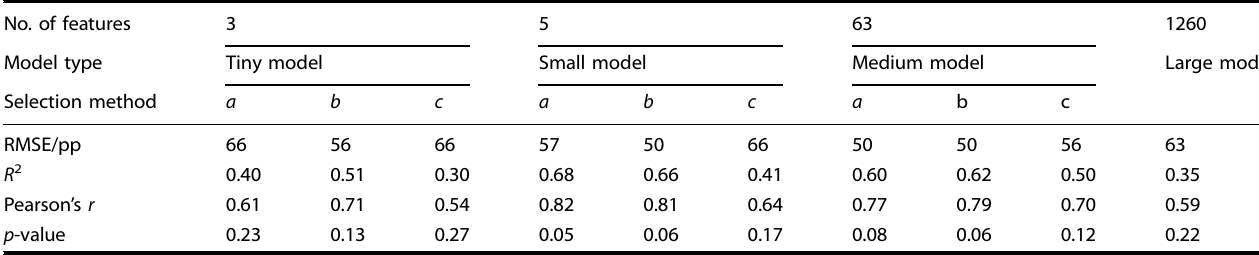
Table 1. Median statistics over the full 10-fold cross